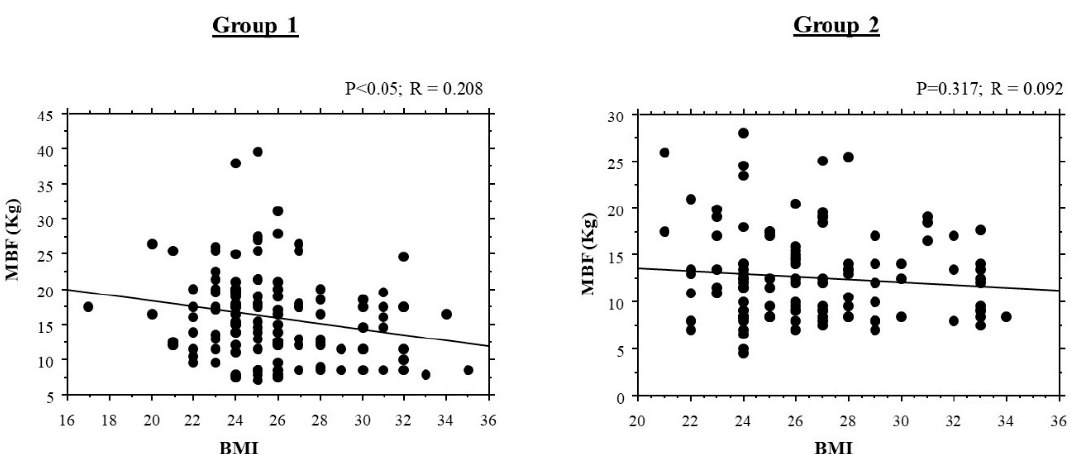
Figure 4. Correlations of maximal bite force with the age of the subjects. MBF = Maximal Bite Force .